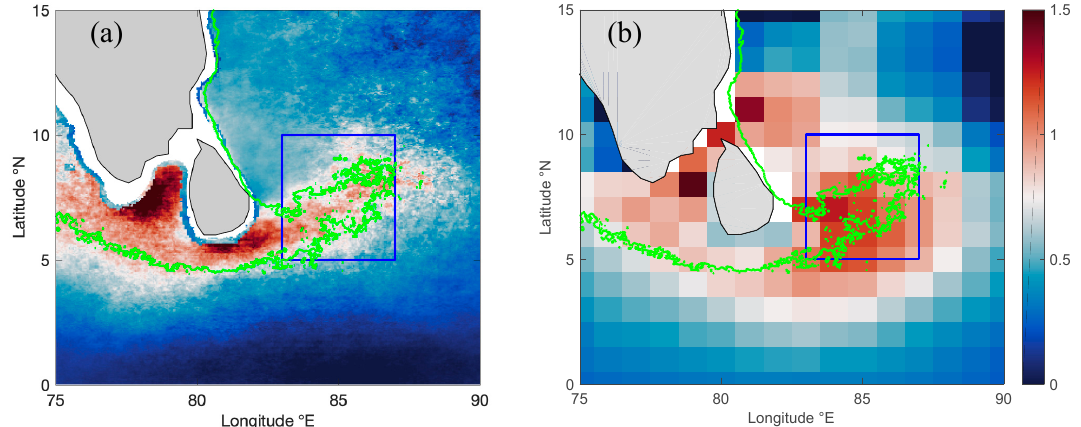
Figure 11. Comparison between ( a ) remote sensing sea-to-air CO 2 flux (units: mol m − 2 yr − 1 ) and ( b ) observation-based product from ref. [52] during the SW monsoon (June–September). Blue boxes denote the region of SLD. Contours denote the chlorophyll concentration of 0.35 mg m − 3 in Figure